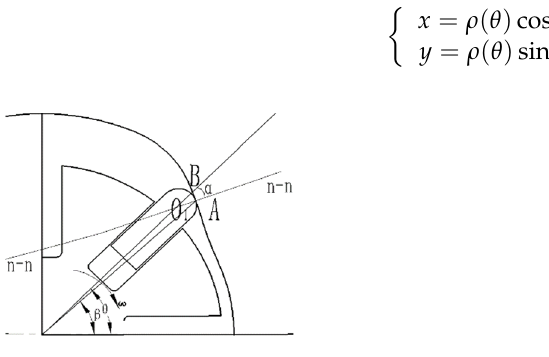
Figure A4. Stator contact angle diagram of slide piece.